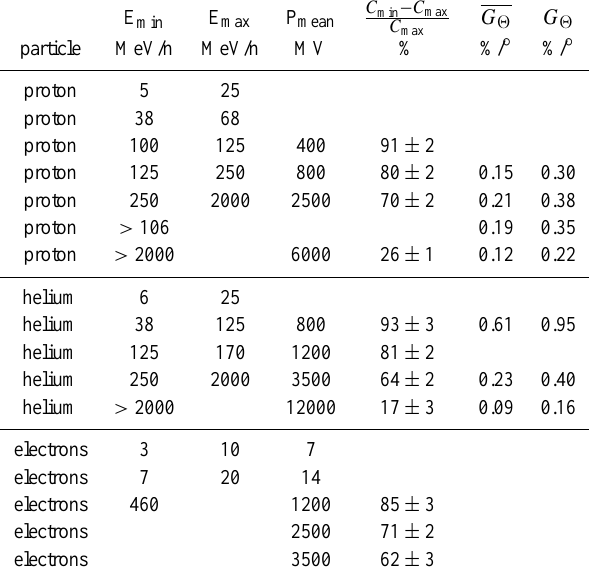
Table 2. KET proton, helium and electron channels used in the cur- rent analysis. The lower ( E min ) and upper energy values ( E max ) have been determined by using a GEANT Monte-Carlo model of the KET. The mean rigidity P mean has been calculated accordingly − C max (Rastoin, 1995). The modulation amplitude C min has been cal- C max culated by using C min and C max , the count rates at solar maximum and minimum in 2000 and 1997, respectively. The mean latitudinal gradient G 2 , and the maximum latitudinal gradient G 2 have been taken from Heber et al. (1996b) for the first latitude